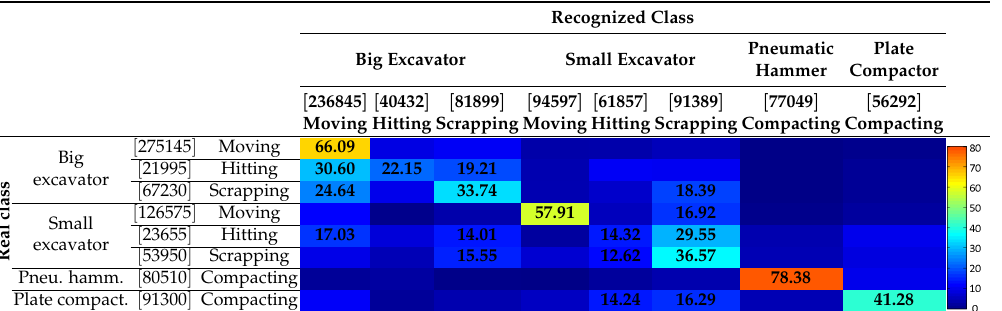
Table 5. Example of confusion matrix table. Classification Accuracy is shown in each cell. The values between brackets represent the number of frames that are classified as the recognized class, or that belong to the real class. ‘Pneu.’ stands for Pneumatic, ‘hamm.’ for hammer, and ‘compact.’ for compactor (reproduced with permission from